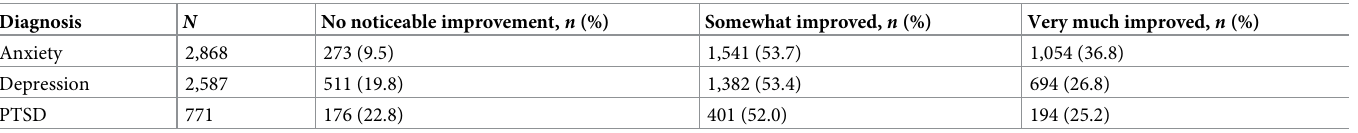
Table 8. Frequencies of reported improvements in mental health